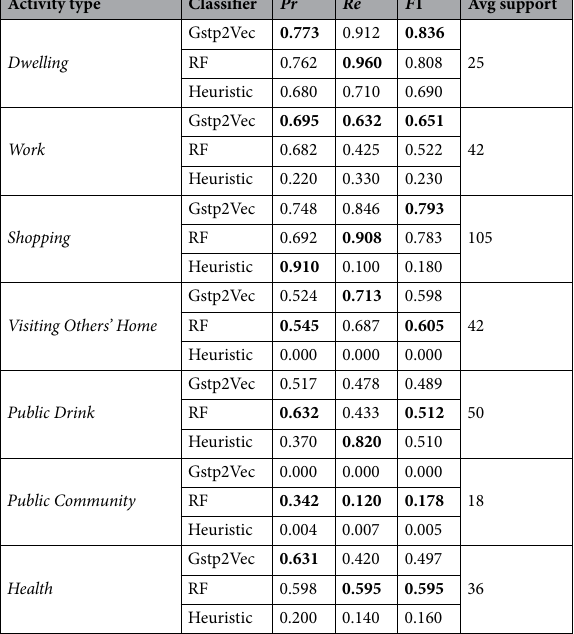
Table 4. Analysis of the precision ( Pr ), recall ( Re ), and F 1 score for identifying seven activity types. Maximum values of the metric for identifying each activity type are in bold.